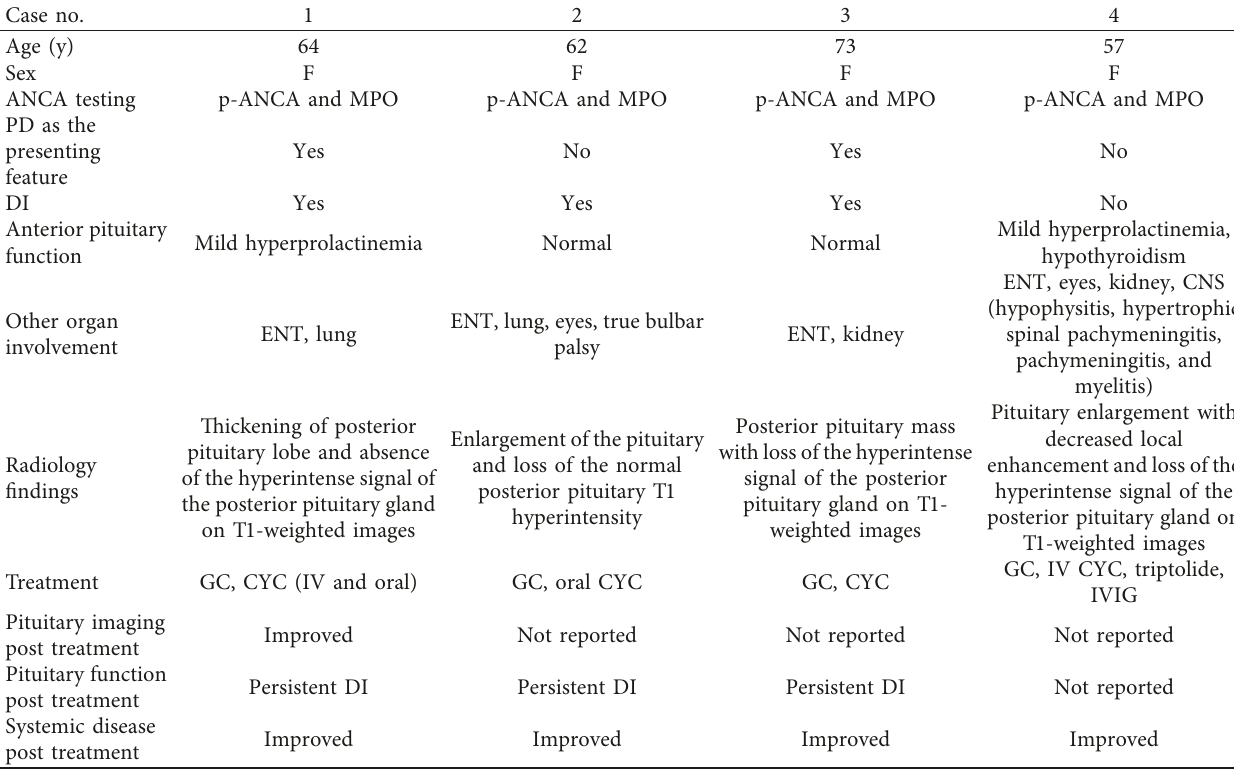
Figure 1: Dynamic magnetic resonance imaging (MRI) of the pituitary (T1-weighted). Enlargement of the posterior pituitary lobe and absence of the hyperintense signal of the posterior pituitary gland on T1-weighted images of patient No. 1 (a). Reappearance of posterior pituitary bright spot and the mass of the posterior pituitary on T1-weighted images of the same patient almost completely resolved after treatment (b). Enlargement of a space-occupying lesion and loss of the normal posterior pituitary T1 hyperintense signal on dynamic MRI of the pituitary (T1-weighted) of patient No. 2 (c, Table 1: Characteristics, ANCA results, pituitary function, radiographic findings, treatment, and outcome of patients with GPA-related pituitary disease.